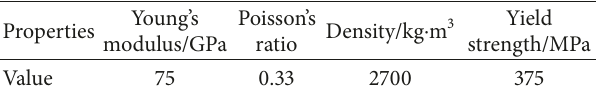
Table 1: Physical parameters of aluminum alloy